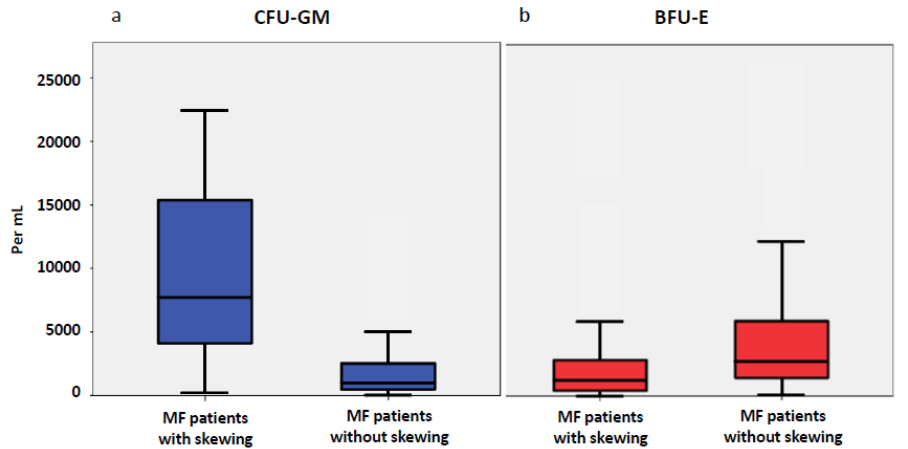
expressed as mean values from duplicate cultures.